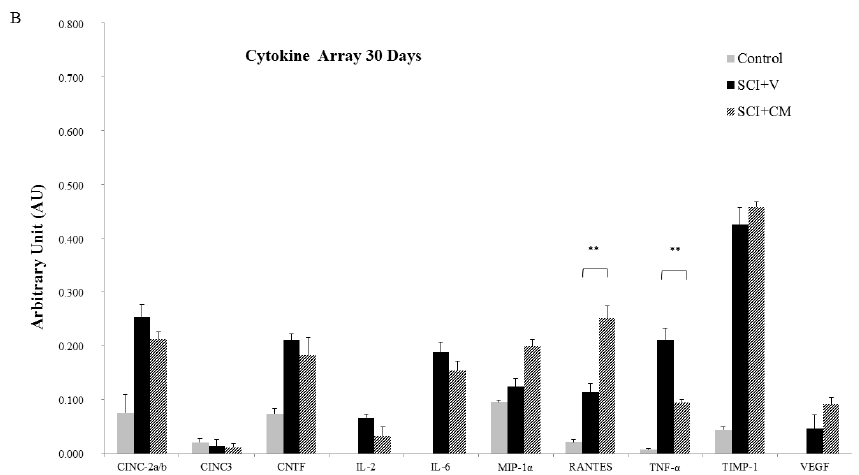
Figure 6. Chemokines and cytokines array after SCI in conditioned media from following groups: Control, SCI + V, SCI + CM. Comparison of cytokines and chemokines secretion at: 15 days ( A ); and 30 days ( B ) in studied groups. Bar diagrams represent the ratio of the spot mean pixel densities/reference point pixel densities. Statistical significance indicated by * p < 0.05, ** p < 0.01.